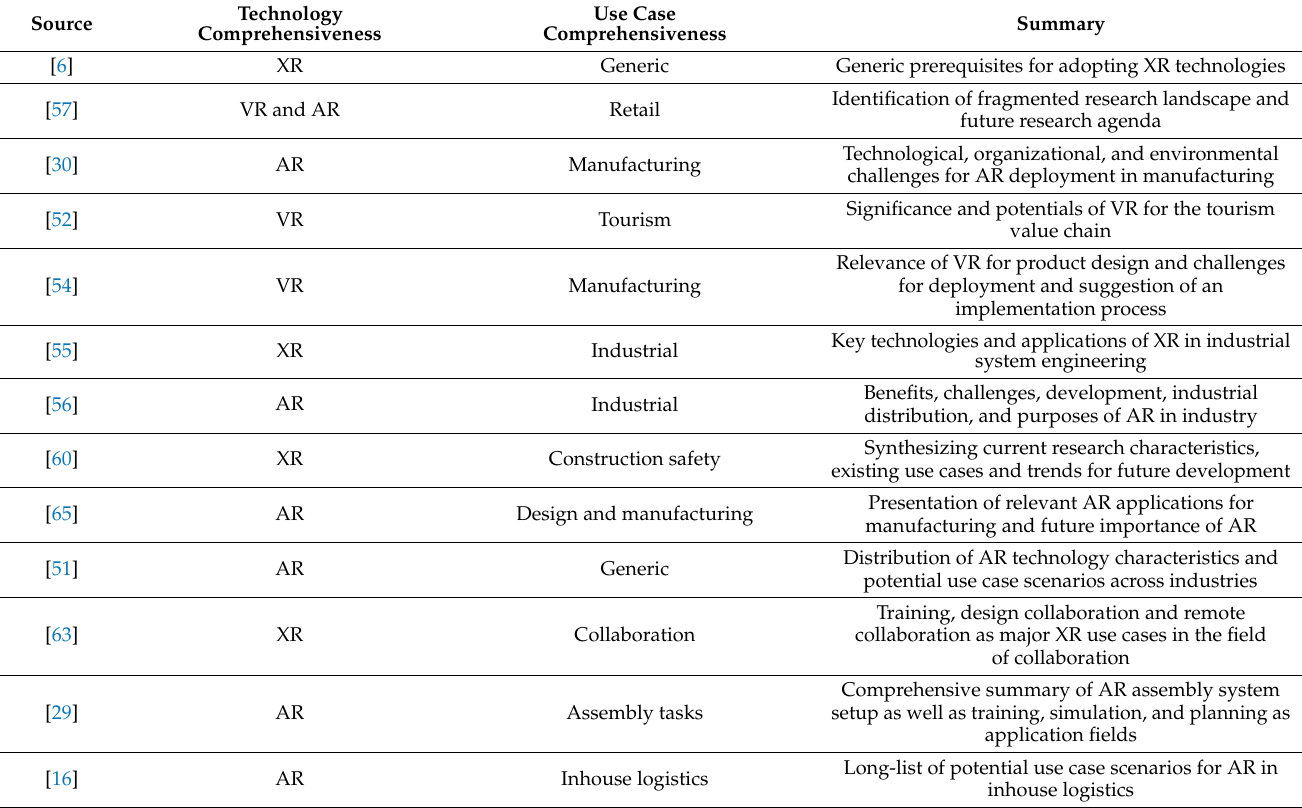
Table 1. Research reviews on XR technologies in value creation.